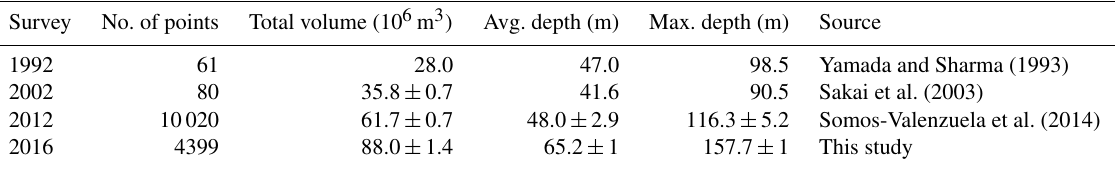
Figure 4. Bathymetric survey of Imja Tsho from June 2016 showing survey tracks. Table 4. Comparison of the 2016 bathymetric survey with previous surveys at Imja Tsho.